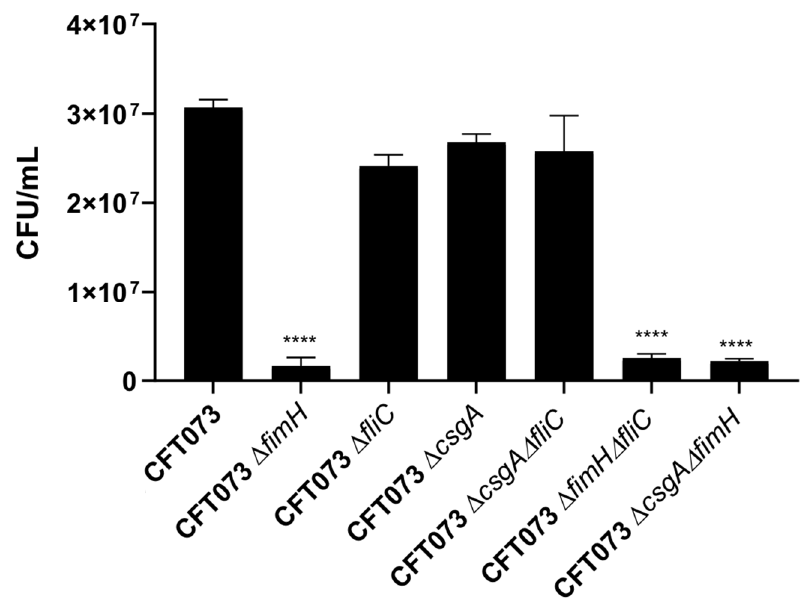
Figure 4. Quantification of adherence to HTB-5 cells. HTB-5 cells were infected with the CFT073 strain or the mutant strains at a MOI of 1:10. The mean ± SEM is shown **** p < 0.0001 compared with cells infected with the reference strain (CFT073).